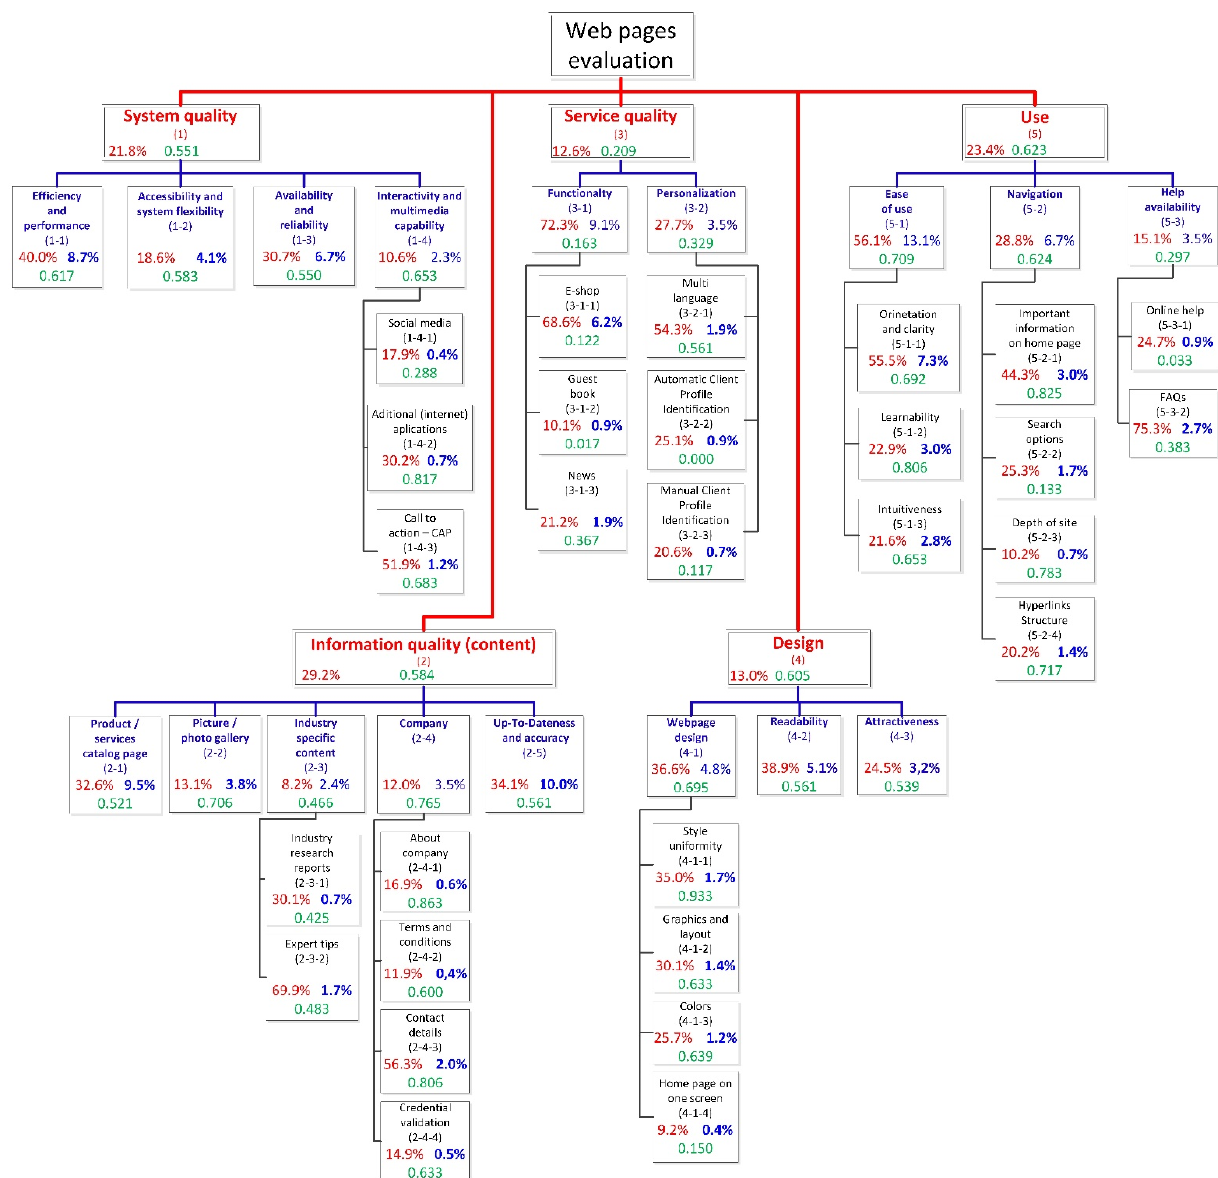
Figure 1. Hierarchical tree of the websites evaluation model with categories, criteria, and sub-criteria weights determined using the AHP method (legend: global weights are blue, local weights are red, average normalized scores are green).